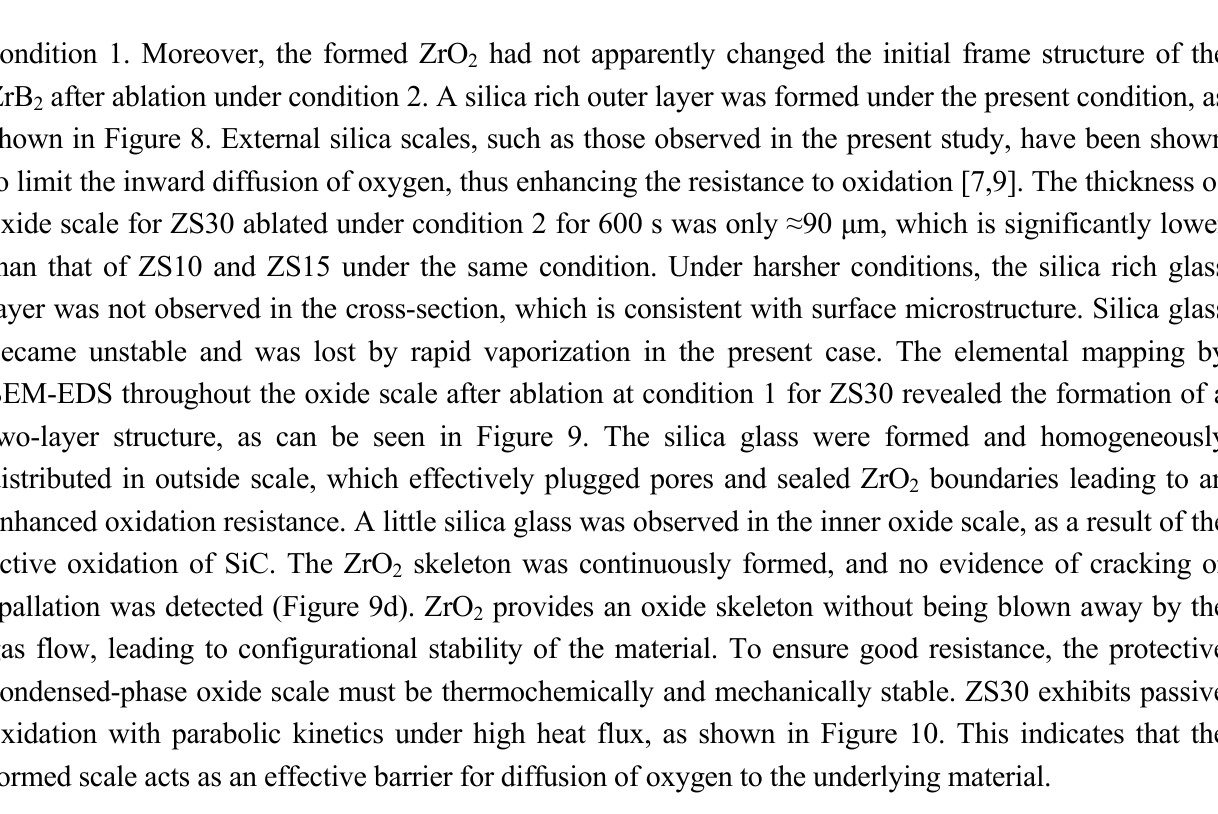
Figure 7. Surface morphologies of ZS30 after ablation under ( a ) condition 1 and ( b ) condition 2.